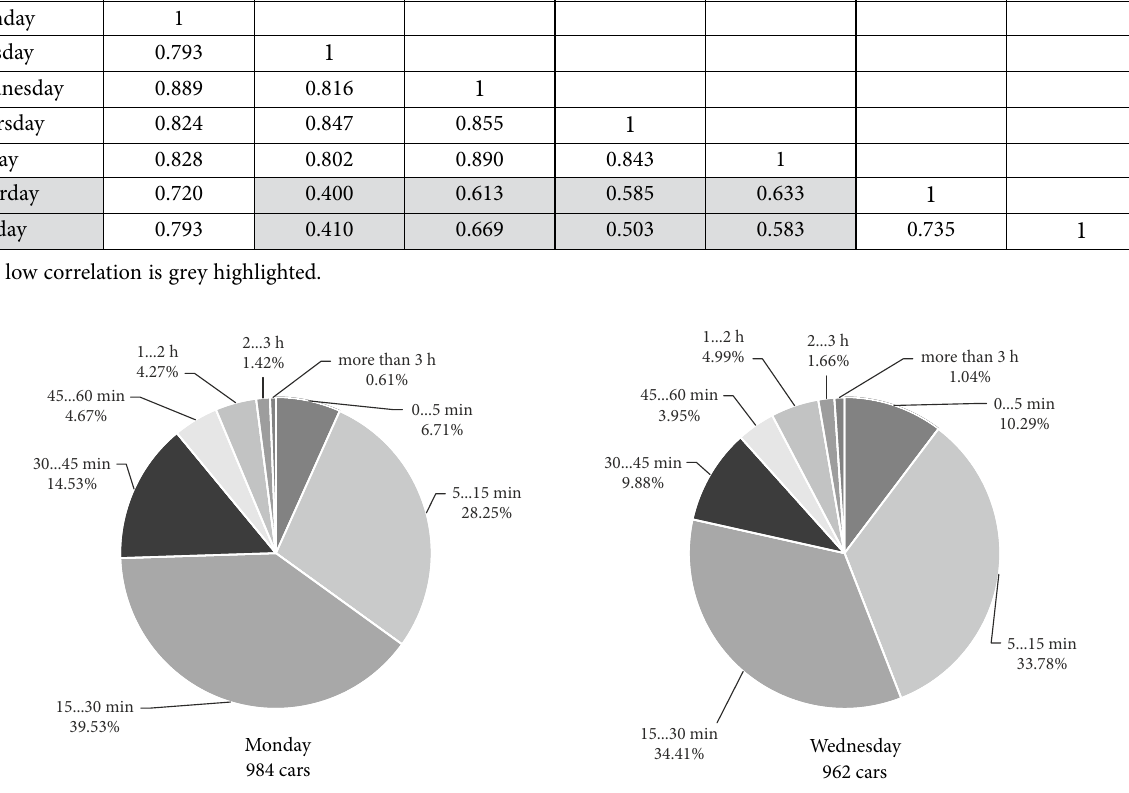
Figure 4. Parking time – example of two days (Monday,